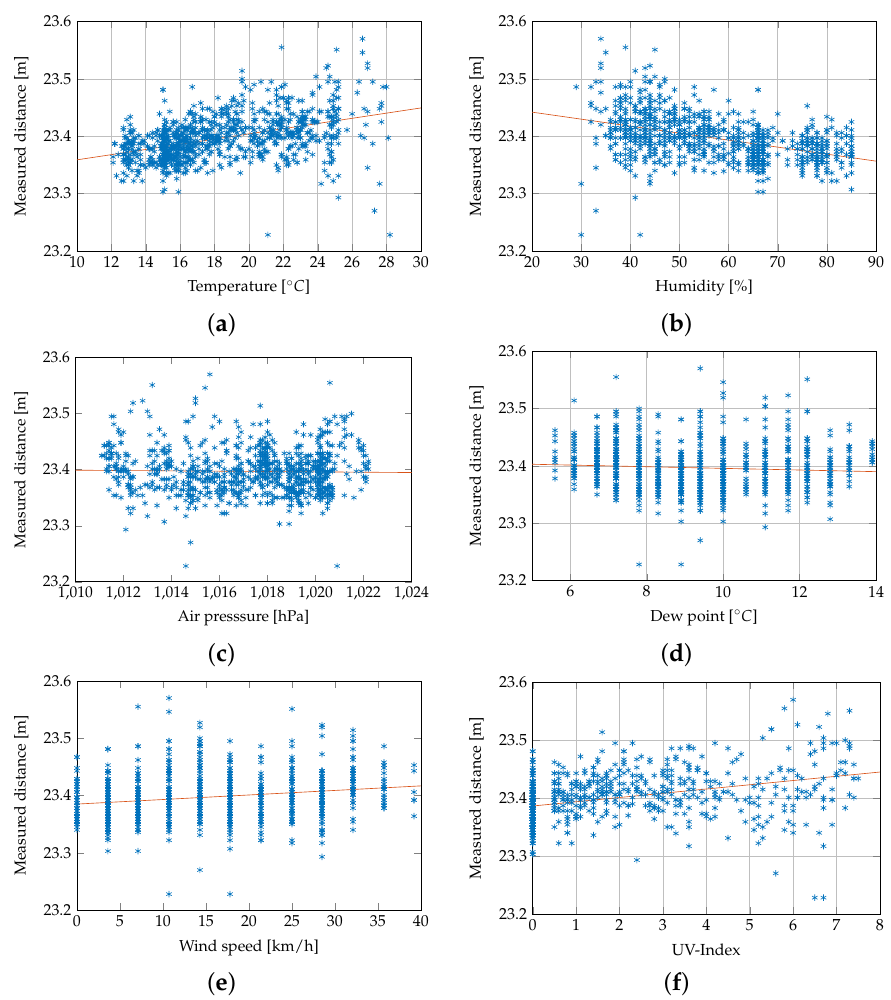
Figure 10. Presentation of measured distance variation with consideration of different weather parame- ters: ( a ) temperature, ( b ) humidity, ( c ) air pressure, ( d ) dew point, ( e ) wind speed, and ( f )